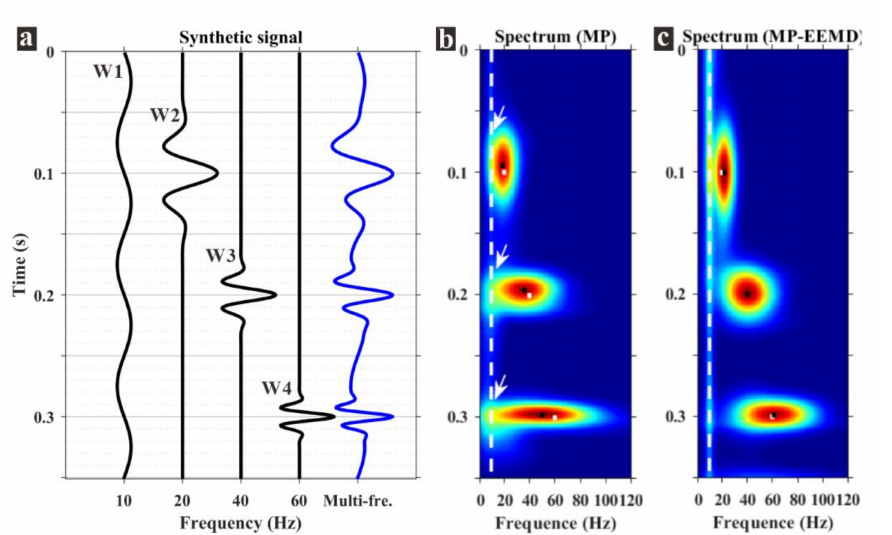
Figure 3. Synthetic signal ( a ), TF spectrum obtained by MP algorithm ( b ), and TF spectrum obtained by MP-EEMD algorithm ( c ). In panel ( a ), the synthetic signal (blue) is obtained by superimposing four wavelets W1–W4 (black), and the specific parameters of wavelets W1–W4 are shown in Table 1. In panels ( b , c ), the white dotted line is the true TF location of W1, the three white points are the true TF centers of W2–W4, the three black points are the TF centers of W2–W4 estimated by spectral decomposition algorithm, the cool colors represent small spectral amplitudes, and the warm colors represent large spectral